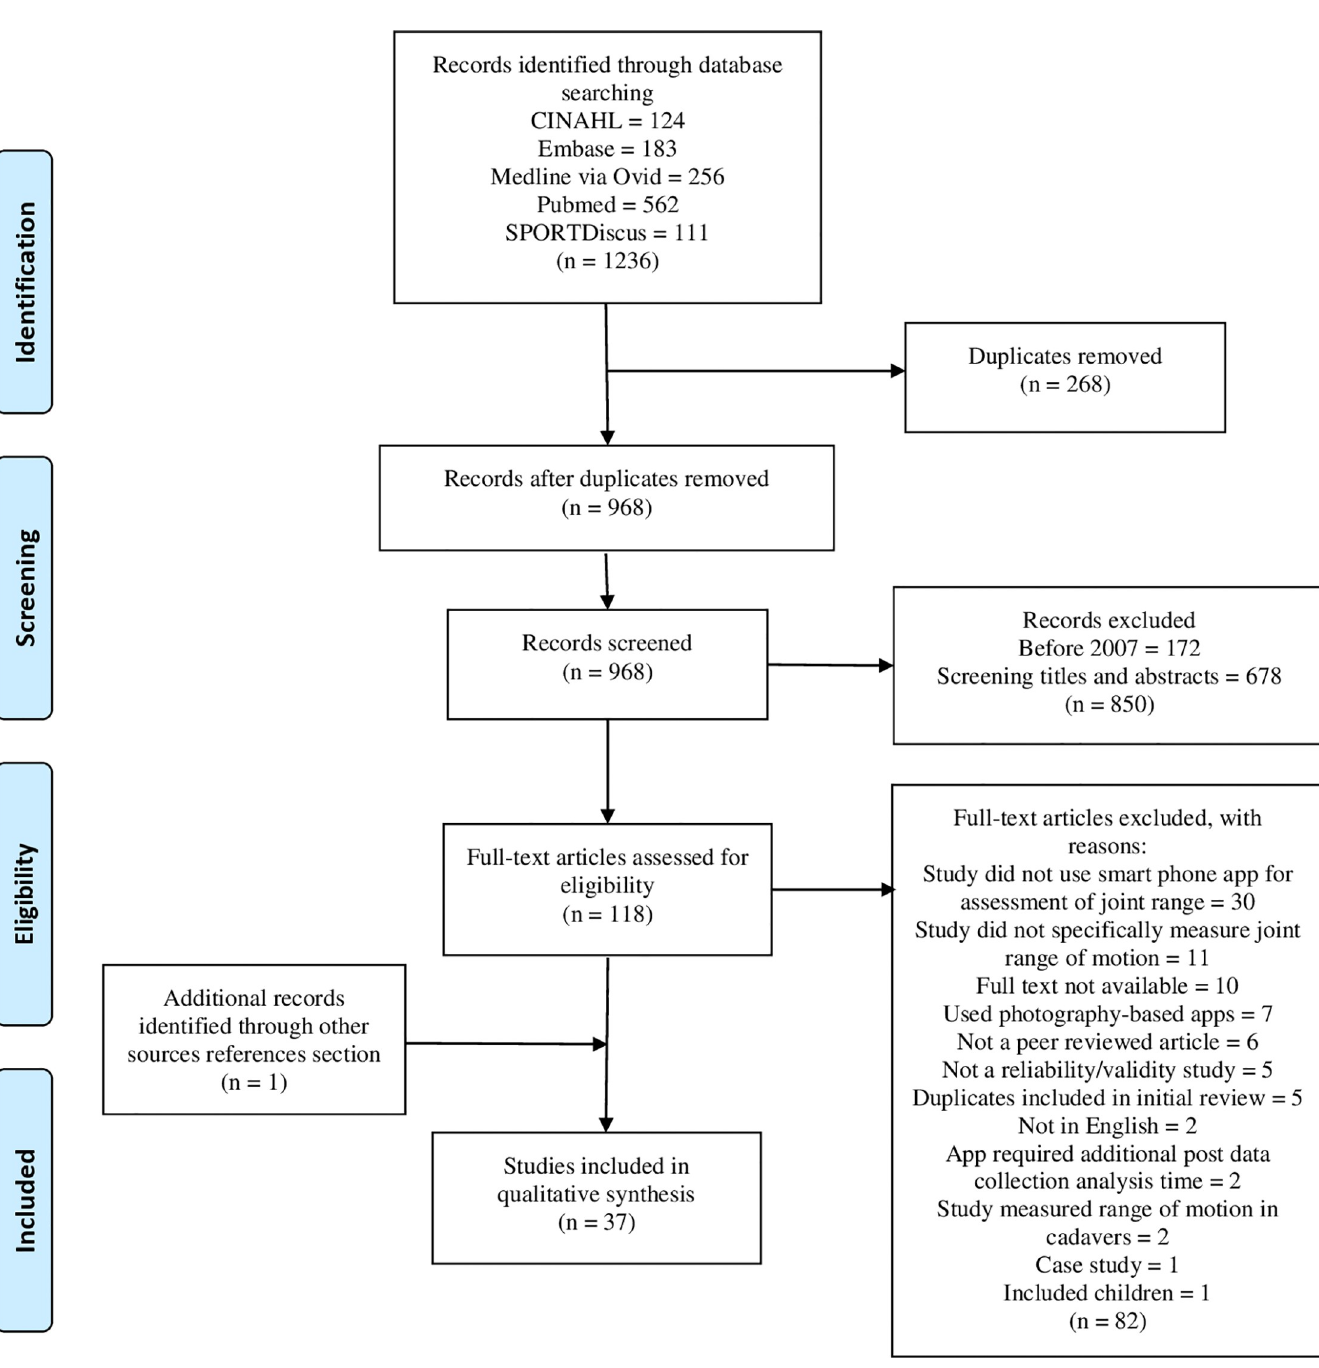
Fig 1. PRISMA flow chart of the screening